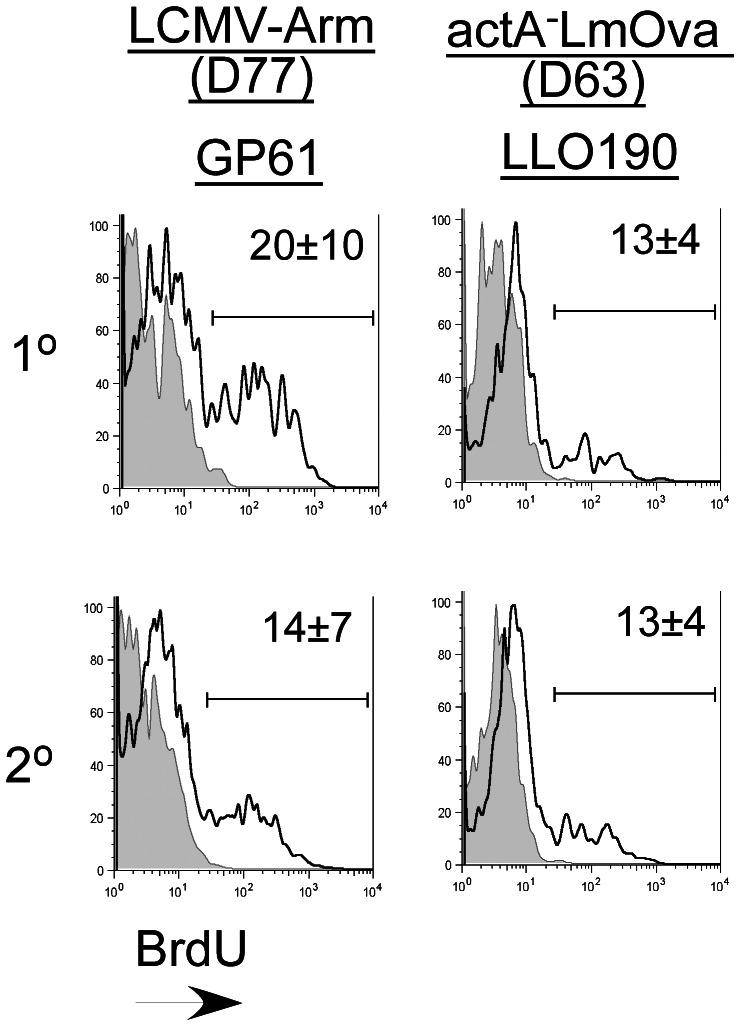
Homeostatic proliferation rates of primary (1°) and secondary (2°) antigen-specific memory CD4-T cells are similar.Homeostatic proliferation was assessed based on BrdU incorporation by antigen-specific 1° and 2° antigen-specific CD4 T cells evaluated simultaneously in the same host at the indicated memory time-points following LCMV and actA−LmOva infection. Each histogram plot is gated on GP61 or LLO190-specific CD4 T cells identified in the spleens and shows the fraction of BrdU+ cells (black line). Isotype control staining is depicted by the shaded grey histograms. Data are representative of results obtained from 3 mice analyzed per group.